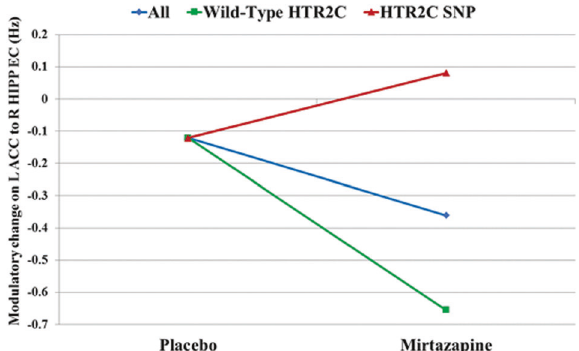
Fig. 4 The mean CW modulatory change of the L-ACC → R-hippocampus (HIPP) EC is illustrated for the HTR2C SNP subgroup (red line), wild-type HTR2C subgroup (green line), and all participants (combined HTR 2C SNP and wild-type HTR2C subgroups) (blue line) upon placebo and mirtazapine scans. The differences between the mirtazapine and placebo scans (mirtaza- pine minus placebo) were all reliable (PP = 1) with 0.2028 Hz, − 0.5327 Hz, and − 0.2390 Hz for the HTR2C SNP, wild-type HTR2C , and all participants, respectively [54, 55, 72 –